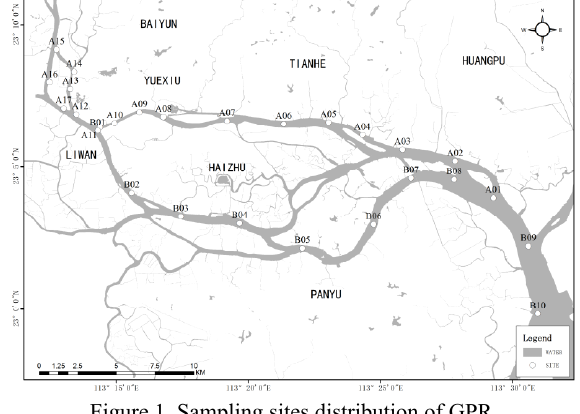
Figure 1. Sampling sites distribution of GPR